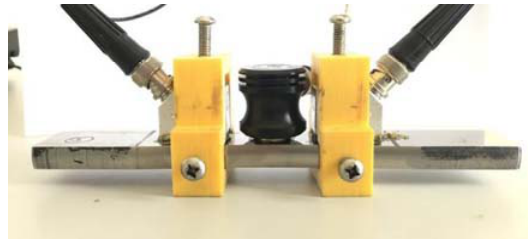
Figure 8. Typical specimen and installed transducers.